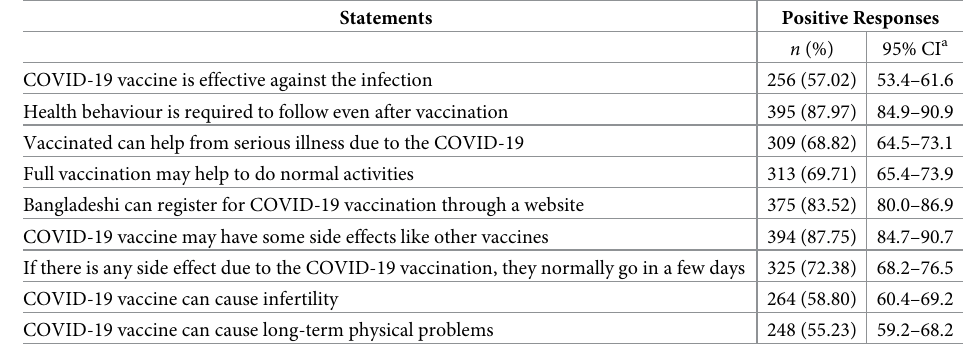
Table 3. Knowledge towards COVID-19 vaccination ( n = 449).